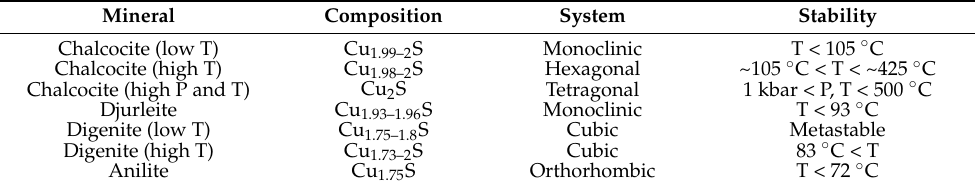
Table 1. Composition, structure, and stability of minerals Cu x S (Data from [19,26]).